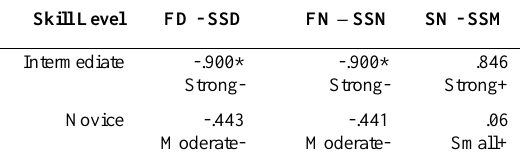
Table 6. Eye- Hand Correlation Results for Scenario-2 Skill Level